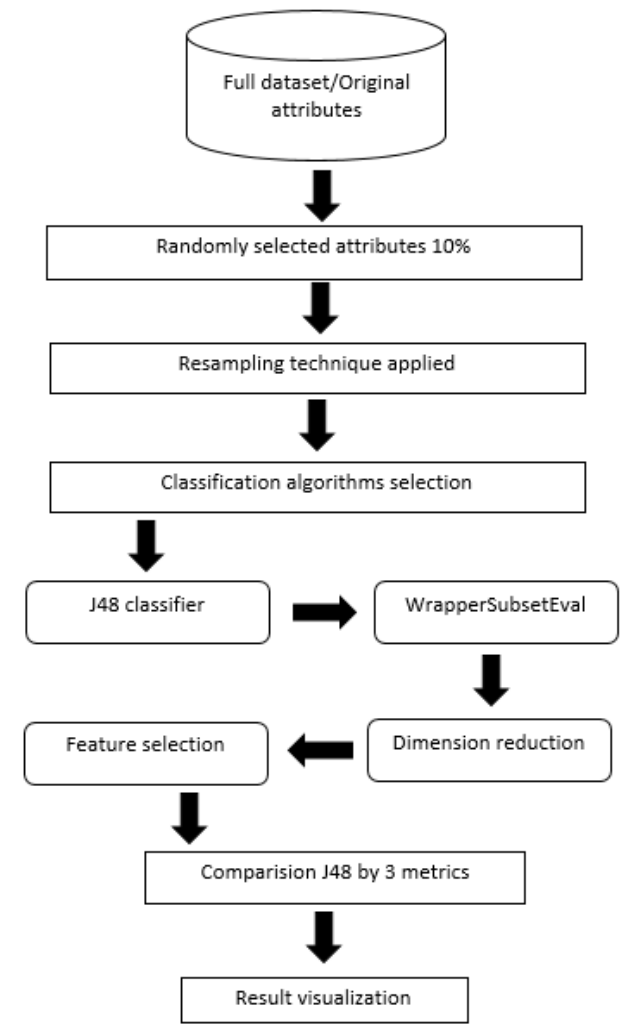
Figure 1. Methodological approach scheme.